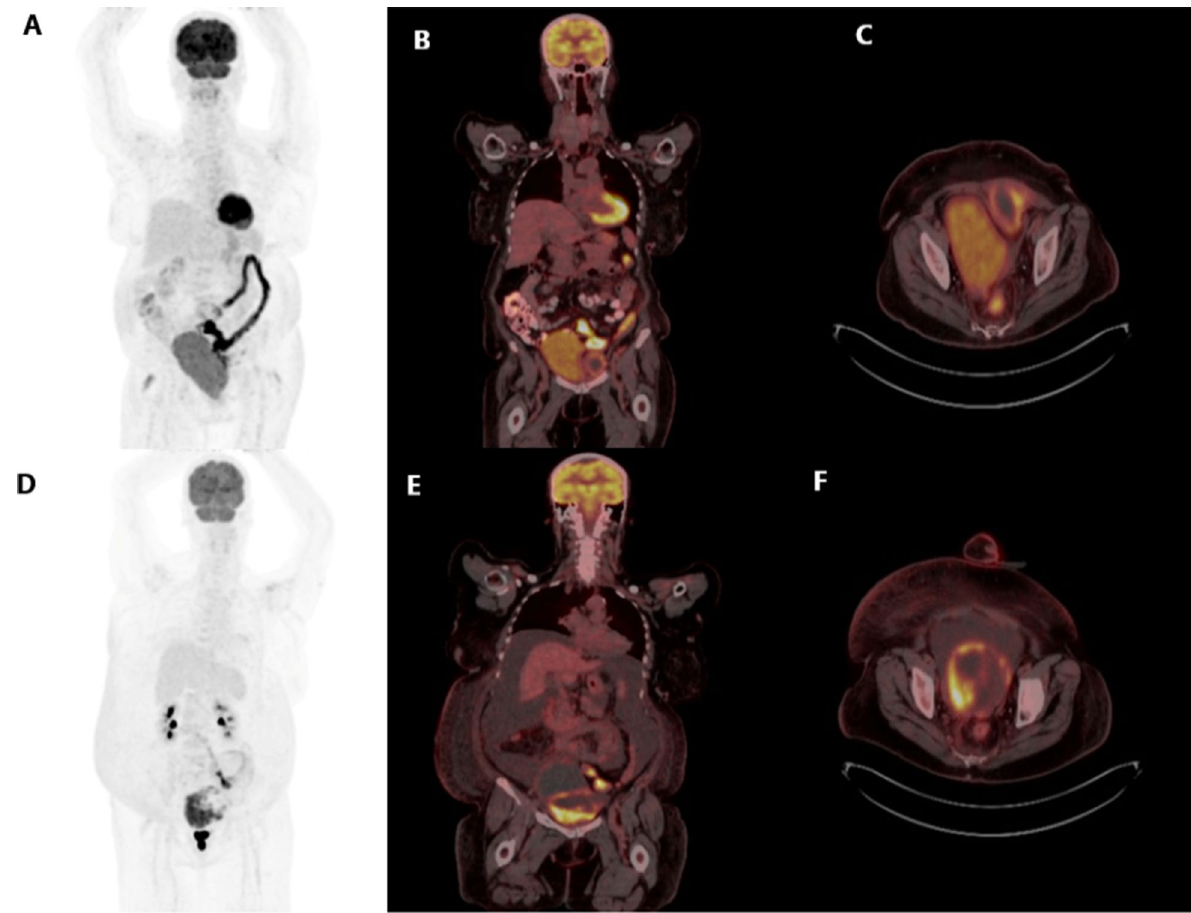
Fig. 3 A 58-year-old man with recto-segmoid carcinoma. A baseline PET/CT scan ( A , B , and C ) revealed a hypermetabolic primary mass with surrounding fluid collection on the right side. There were also active nodal lesions in the pelvis. The post-therapy PET/CT scan ( D , E , and F Figures) is consistent with a progressing disease state, as evidenced by increasing activity of the primary mass and the emergence of adherent large heterogeneous pelvic mass and small mesenteric sub-centimetric active lymph nodes. Current regression of the old pelvic nodal lesion and the resolution of the pelvic fluid collection and development of pelvi-abdomianal